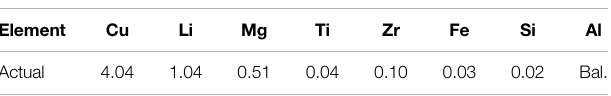
TABLE 1 | Chemical composition of 2195 Al-Li alloy (wt%).